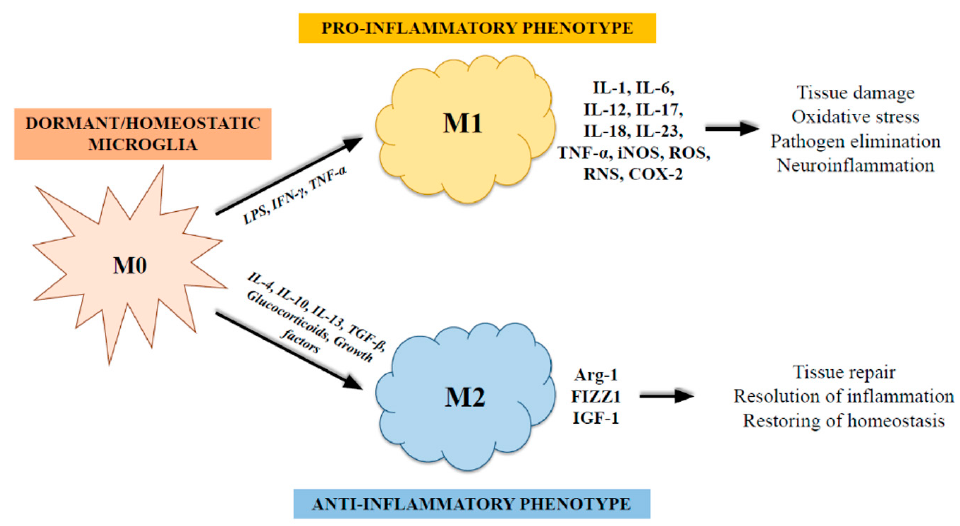
Figure 1. The two primary activation phenotypes of microglia. In physiological conditions, the microglia are dormant (M0). Injurious circumstances can cause the activation of resting microglia into distinct phenotypes, M1 and M2, having a proinflammatory phenotype (inducing neurological damage) and taking part in resolution of inflammation (with a neuroprotective role), respectively.